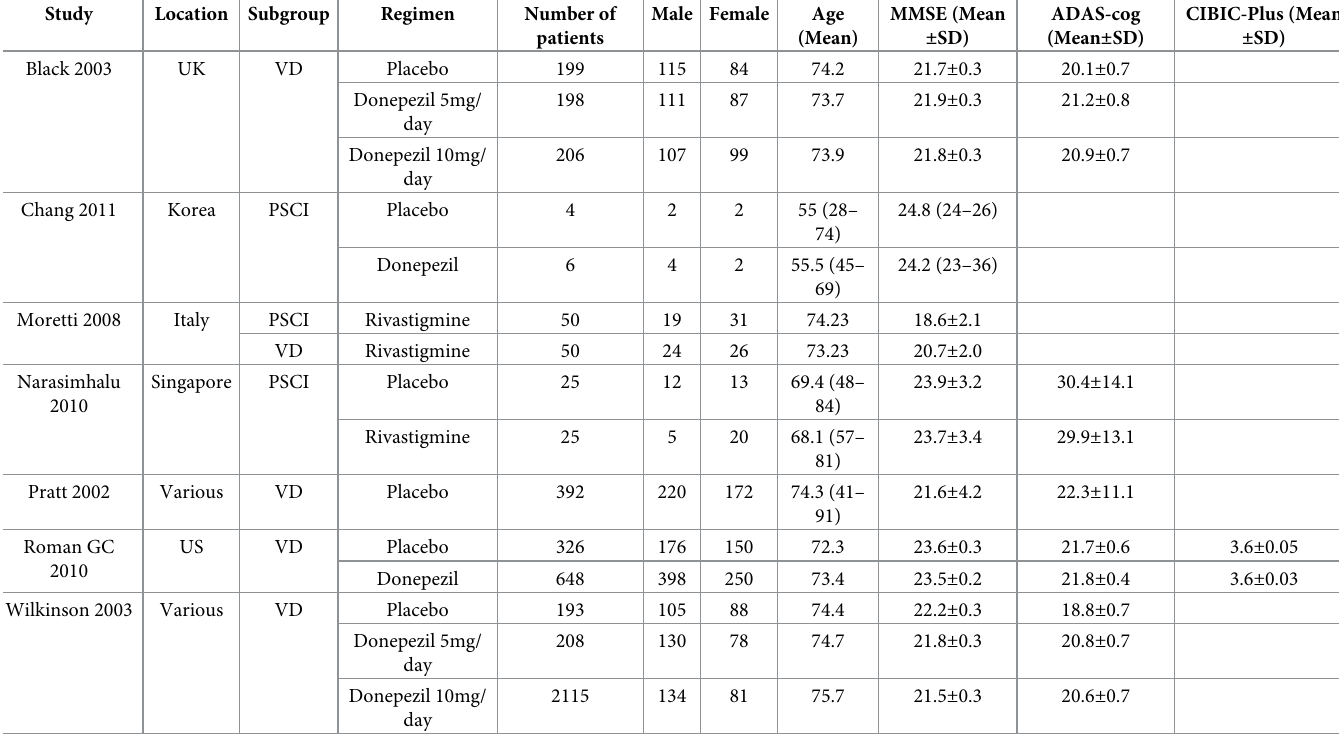
Table 1. Main characteristics of the eligible